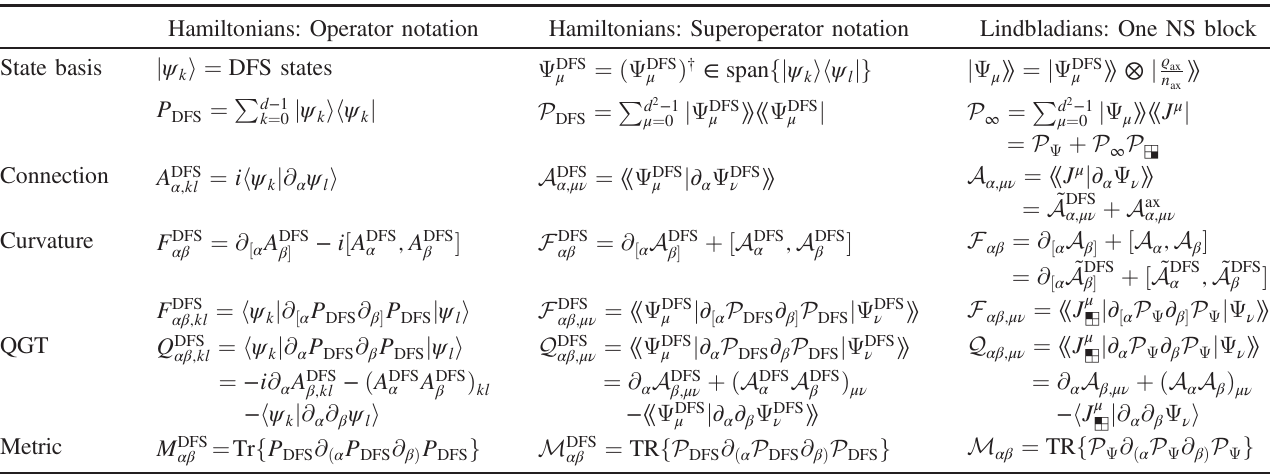
TABLE I. Summary of quantities defined in Secs. V and VI. Hamiltonians: Operator notation Hamiltonians: Superoperator notation Lindbladians: One NS